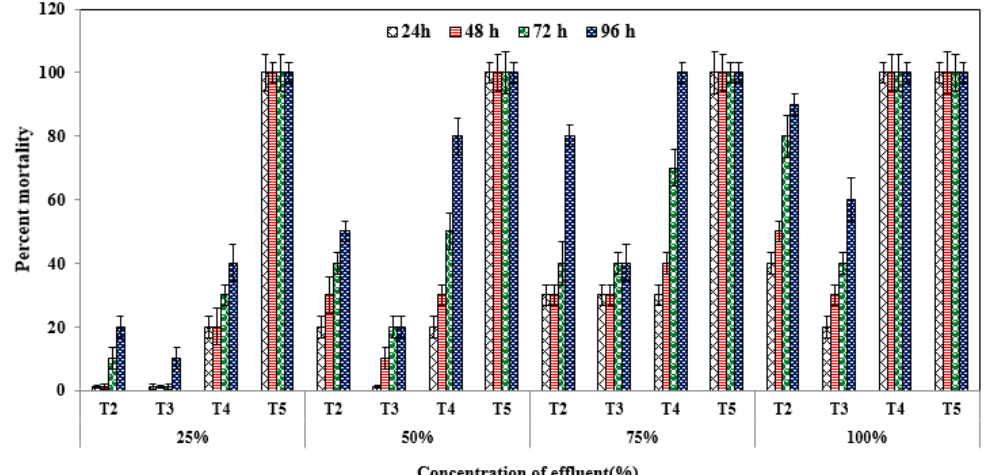
Figure 2. Mortality in fish on exposure to different concentrations of untreated and treated effluent by CWs using Leptochloa fusca. Tannery effluent treated in CWs with L. fusca only (T2), effluent treated in CWs with L. fusca and bacteria (T3), effluent treated in CWs without vegetation (T4), and raw tannery effluent (T5). Each value is mean ± standard error and number of replicates for each treatment ( n ) = 3.